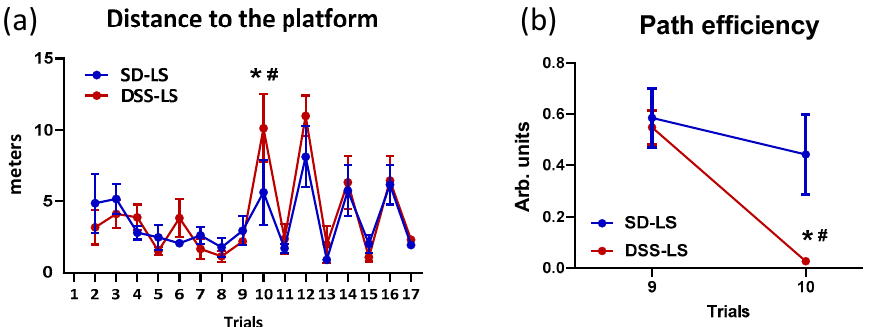
Figure 2. Morris water maze (MWM) behavioral test results. MWM test was performed in four- month-old Sprague–Dawley (SD; n = 8; blue line) rats and four-month-old Dahl salt-sensitive (DSS; n = 7; red line) rats, which were kept on a low-salt (LS) diet. Values are expressed as mean ± SEM. ( a ) Distance to the platform in affected MWM test. Visible platform: trials 1–9, 11, 13, 15, and 17; invisible platform: trials 10, 12, 14, and 16. ( b ) Path efficiency in MWM. The differences between trials 9 (visible platform) and 10 (invisible platform) are presented. Two-way ANOVA with false discovery rate (FDR) correction: * p < 0.01, for trial 9 vs. trial 10; # p < 0.05, for SD vs. DSS. The DSS rats traveled longer distances to find the invisible platform vs. visible platform in comparison to the SD rats.